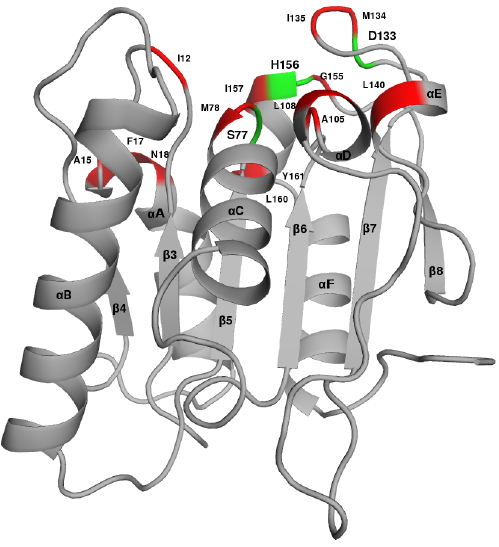
Figure 1. Bacillussubtilis Lipase A structure. The catalytic triad residues are shown in Green, and active site residues are shown in Red. The secondary structures ( a -helices and b -strands) are labeled. doi:10.1371/journal.pone.0102856.g001 PLOS ONE |